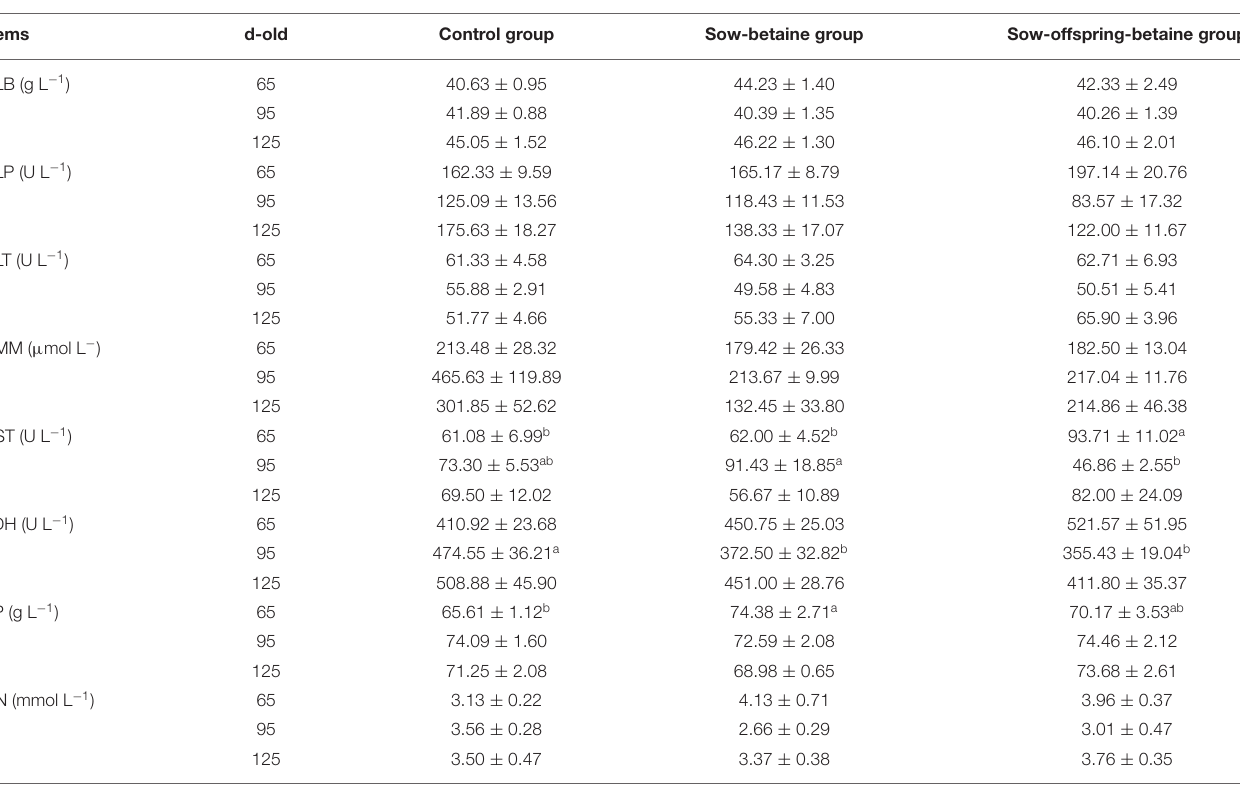
TABLE 5 | Effect of dietary betaine on plasma biochemical parameters of Bama